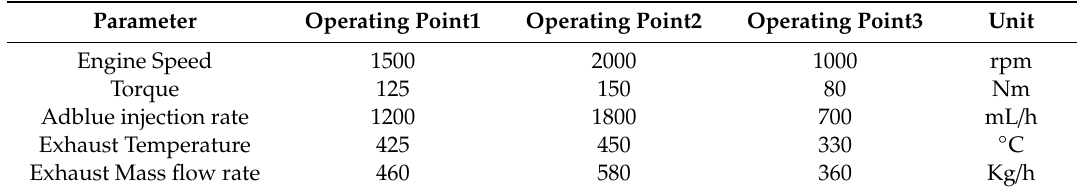
Table 2. Simulation calculation boundary conditions.